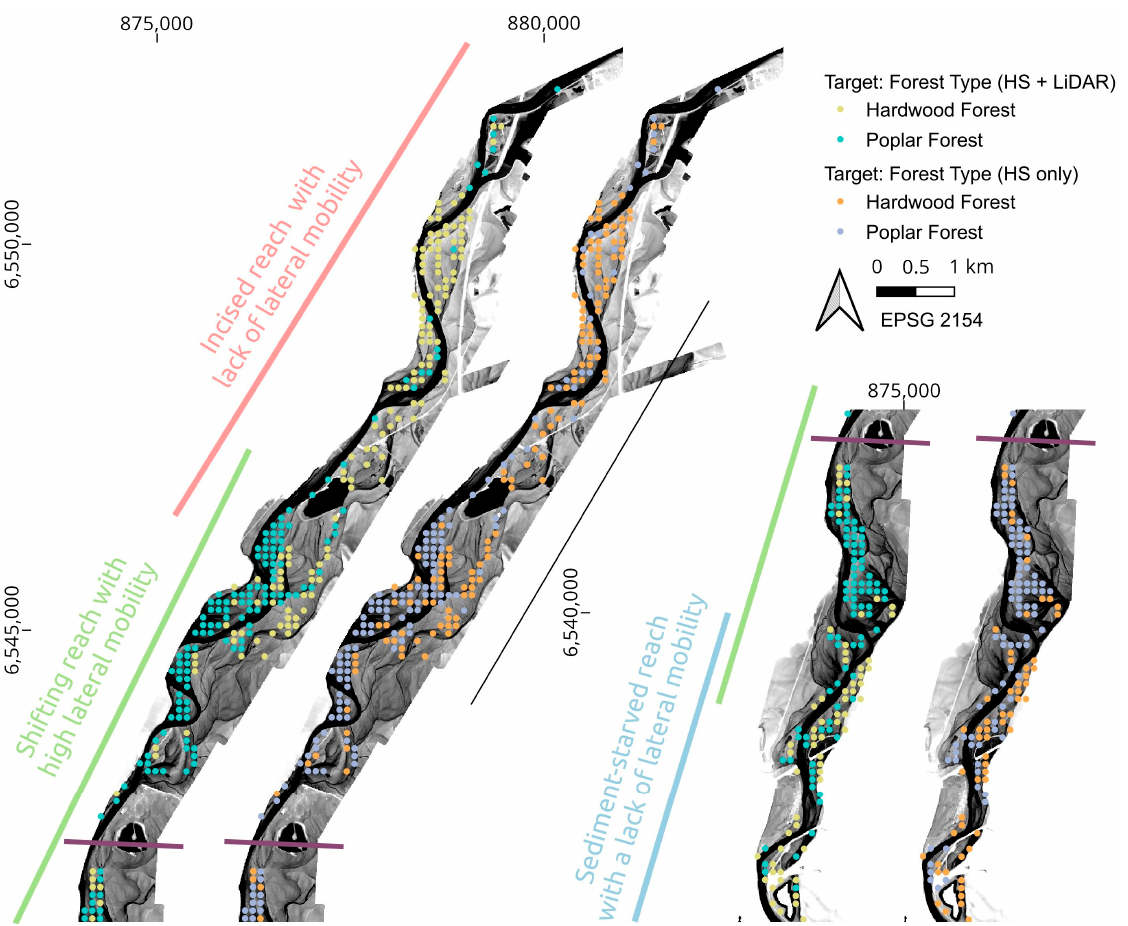
Figure 14. Comparison of forest-type prediction between the map resulting from both LiDAR and hyperspectral data and the map resulting from only hyperspectral data.